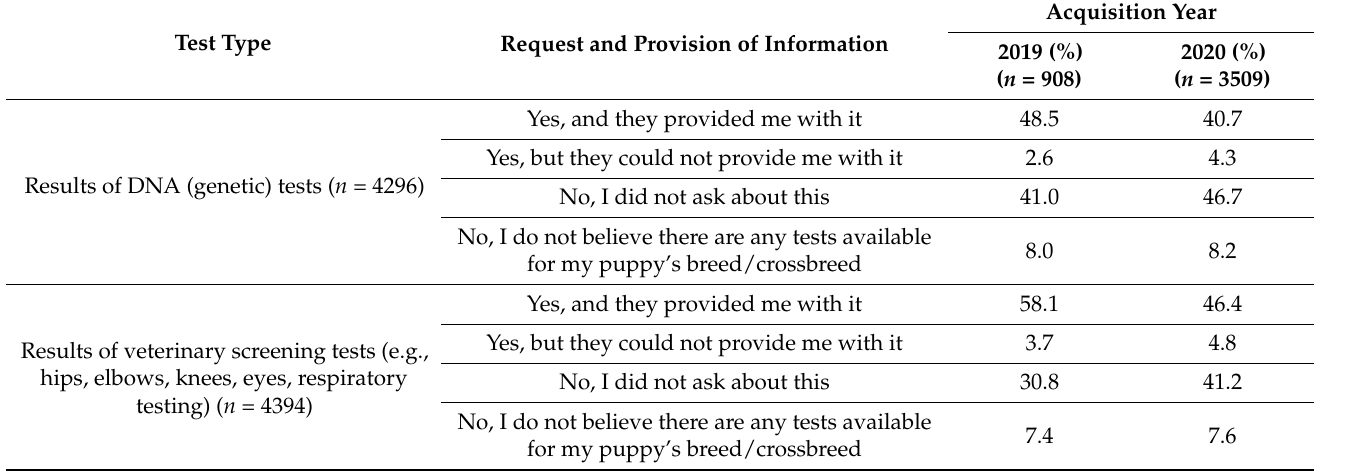
Table 12. Owners’ requests for information related to health testing of their puppies’ parents with comparison between 2019 puppy owners ( n = 908) and Pandemic Puppy owners ( n = 3509) in the